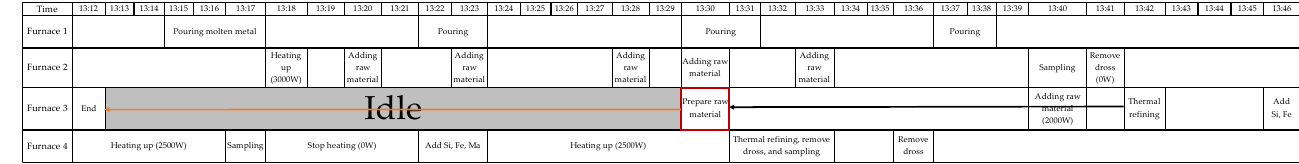
Table 1. An example of actions of four furnaces with electricity settings.